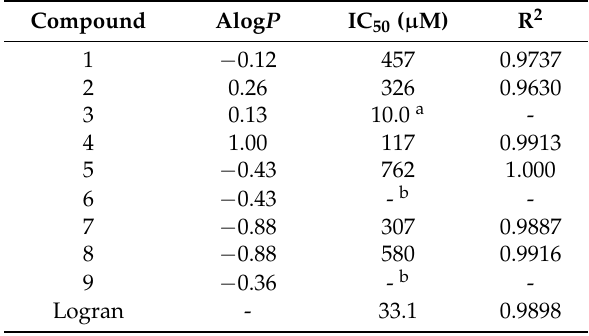
Figure 2. Activity of compounds 1 – 9 in the etiolated wheat coleoptile bioassay. Results are given in % from the control coleoptile length. Positive values indicate a higher growth than the control and negative values a lower growth than the control. Table 1. IC 50 and Alog P values for compounds 1 – 9 . IC 50 was calculated only for those that reached the 50% of inhibition in the bioassay. a Tested concentration at which the inhibition was − 50%. b Tested compound which not reached 50% inhibition.